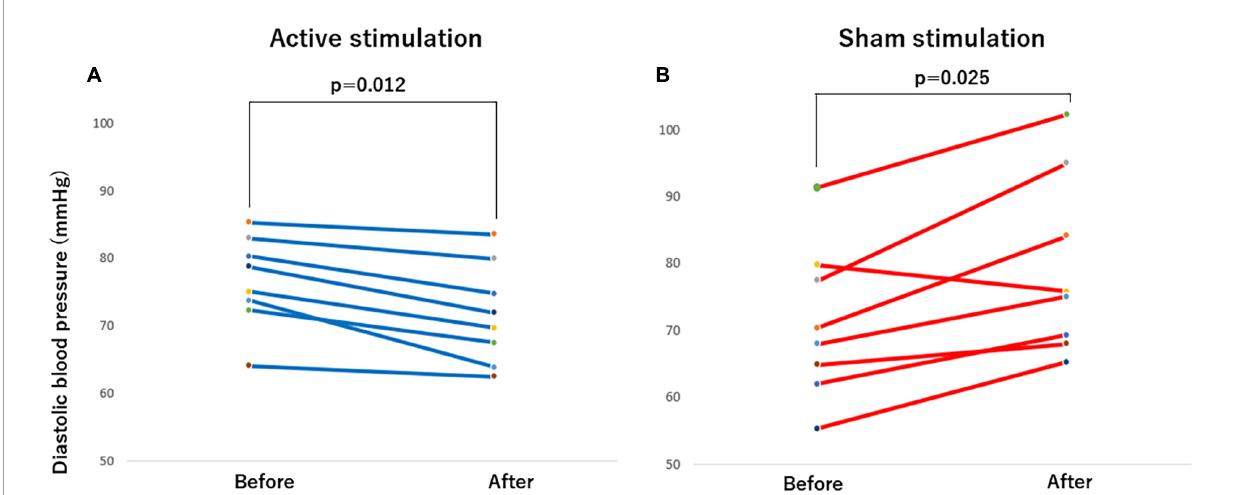
FIGURE6 Effect of active vs sham tVNS on measures of brachial diastolic blood pressure. (A) Active stimulation. (B) Sham stimulation. tVNS, transcutaneous vagus nerve stimulation.